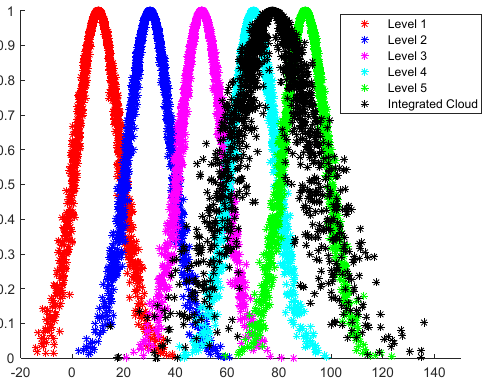
Figure 9. Construction environmental risk integrated cloud vs. standard cloud.